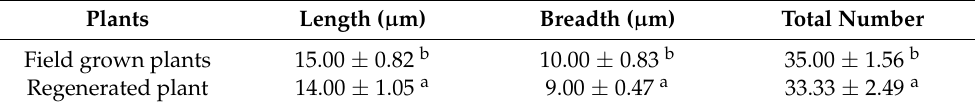
Table 5. Structure and density of stomatal apparatus of regenerated and field grown (donor) plants. Plants Length ( µ m) Breadth ( µ m) Field grown plants